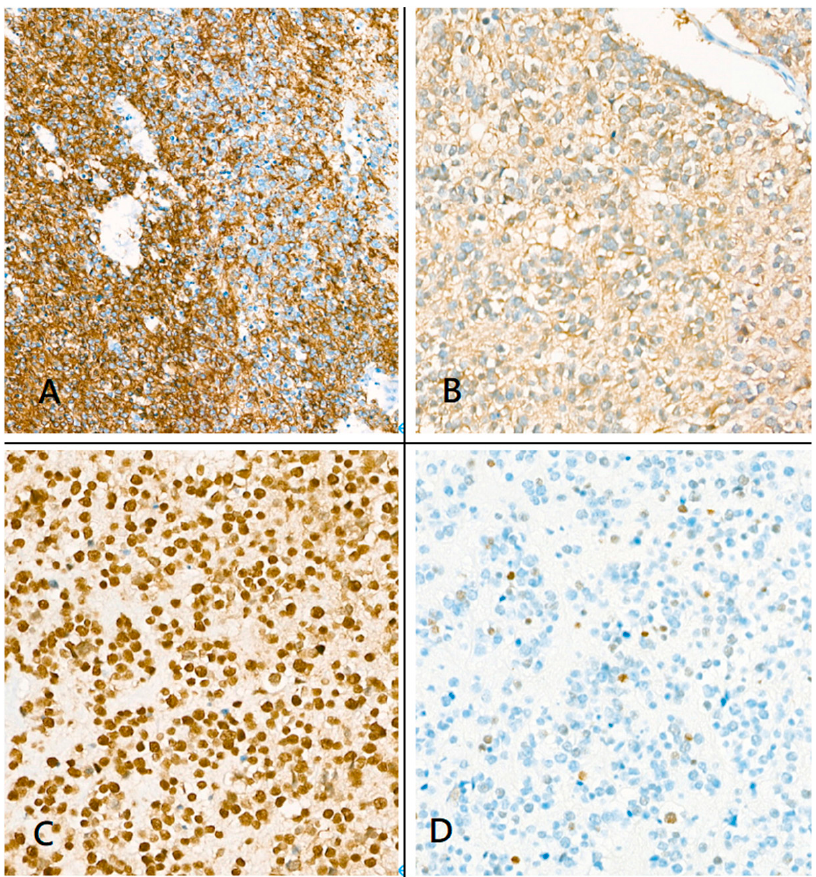
Figure 6. Immunohistochemical staining. ( A ) Immunohistochemistry showed that the tumor was positive for glial fibrillary acidic protein; ( B ) Isocitrate dehydrogenase-1-positive staining; ( C ) Alpha-thalassemia/intellectual disability X-linked-positive staining; ( D ) p53 staining showed a wild-type pattern.